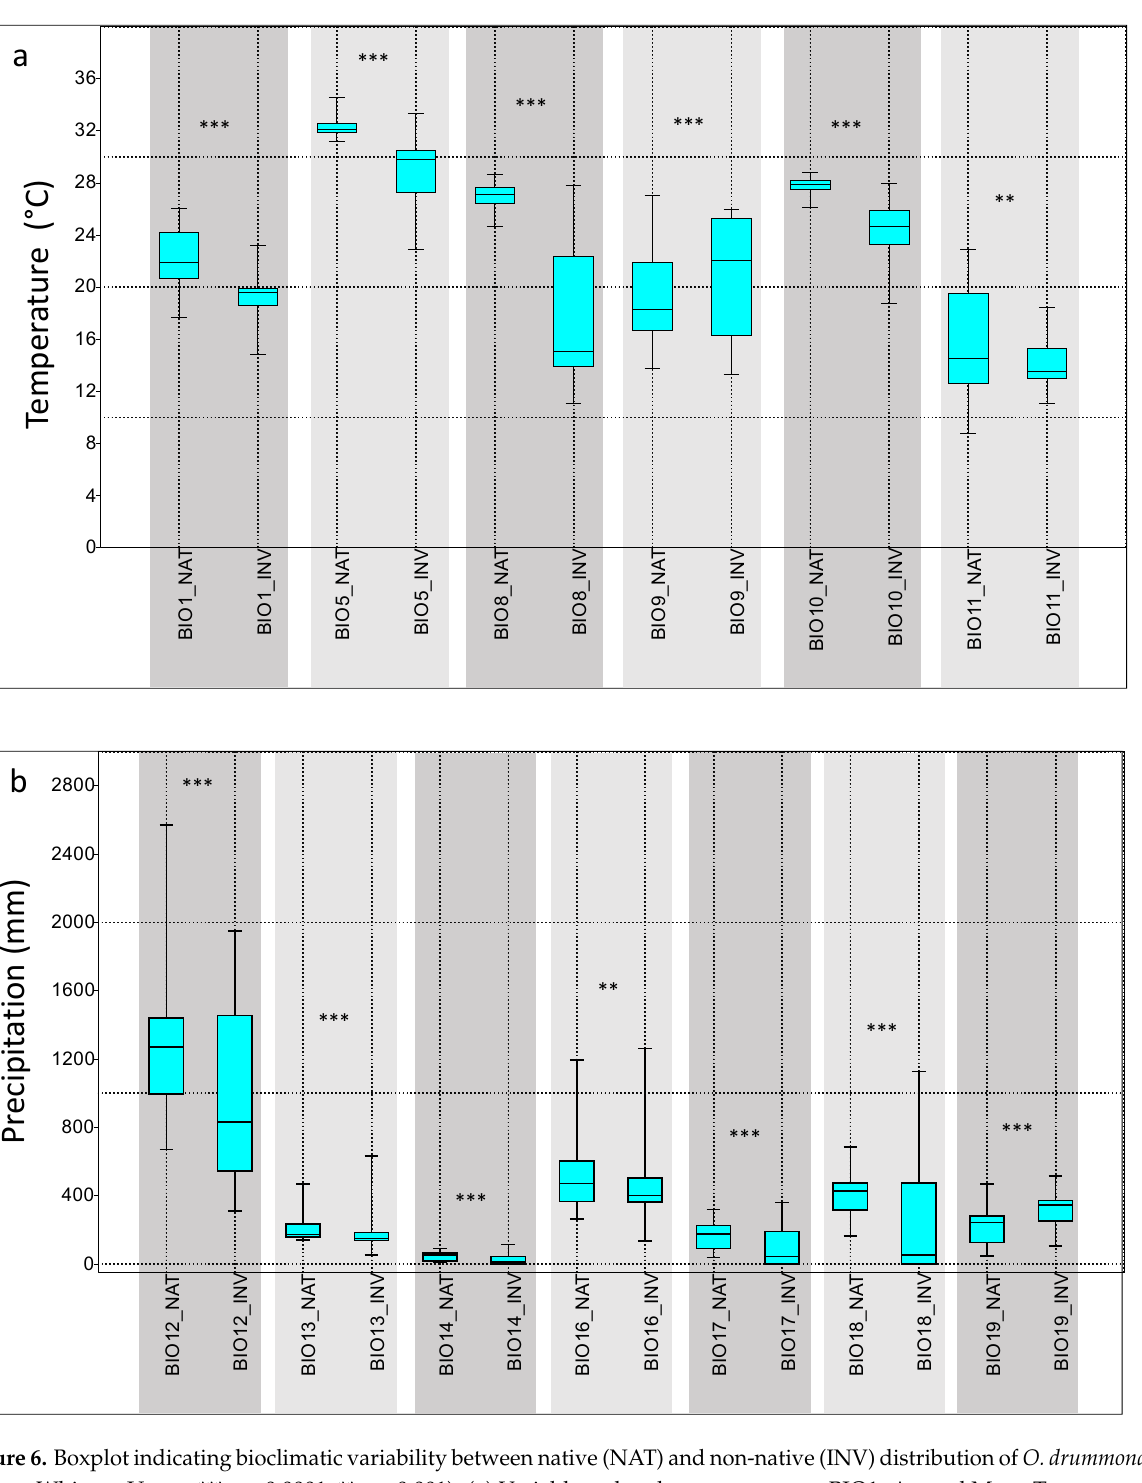
Figure 6. Boxplot indicating bioclimatic variability between native (NAT) and non-native (INV) distribution of O. drummondii . (Mann–Whitney U test: *** p < 0.0001, ** p < 0.001). ( a ) Variables related to temperature. BIO1: Annual Mean